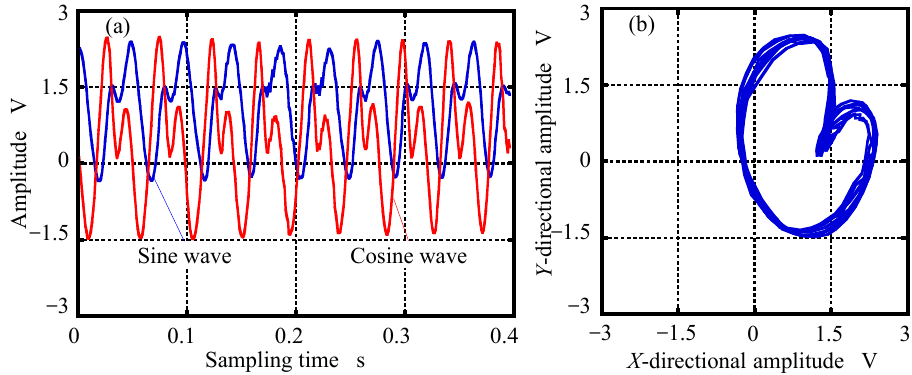
Figure 2. Distorted signals: ( a ) sinusoidal and cosine signals and ( b ) Lissajous figure.